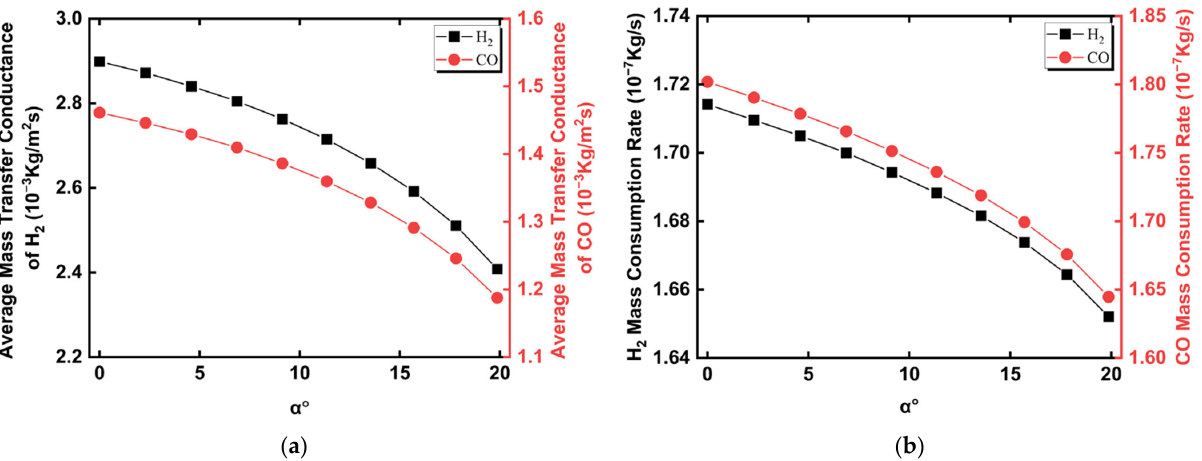
Figure 16. The effect of the conical ring offset angle on: ( a ) the mass transfer conductance and ( b ) the fuel consumption rates.